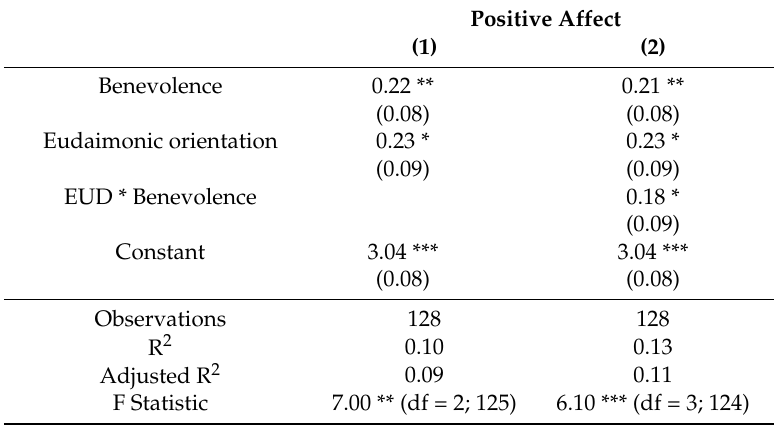
Table 3. Regression results using eudaimonic orientation as a moderator.